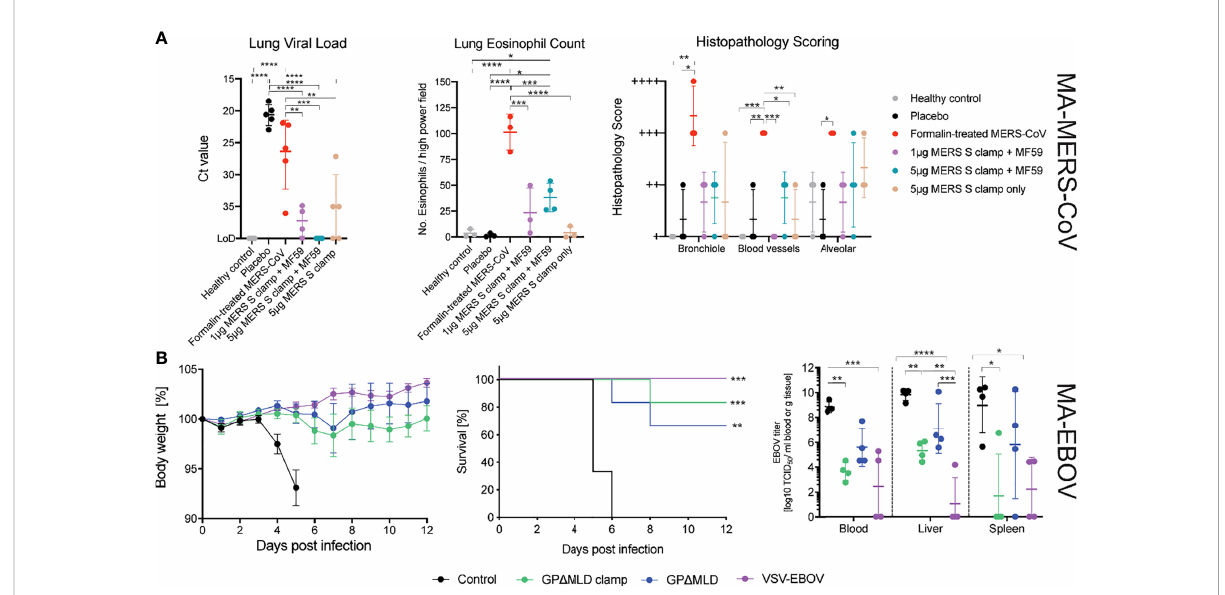
FIGURE 4 MERS-CoV and EBOV challenge models. (A) Congenic C57BL/6 DPP4 knock-in mice were given prime and boost immunisations before challenge with 10 4 PFU of MA-MERS. The tissues were then assessed for in fi ltration of the virus and histopathology. Asterisks indicate statistical signi fi cance calculated by a two-way ANOVA with Tukey ’ s multiple comparisons test. (B) Syrian golden hamsters were immunised with clamped in fl uenza virus H3 hemagluttinin (control), clamp-stabilised and unstabilised recombinant GP D MLD or VSV-EBOV and challenged with 1,000 LD 50 of MA-EBOV (n = 10). Body weights and survival of the hamsters was monitored following the challenge (n = 6). Four days post-challenge, hamsters were euthanized for virological analysis of the blood and tissues (n = 4). Statistics are calculated using a two-way ANOVA grouped analysis with Tukey ’ s multiple comparisons test. Survival curves were analysed with a Mantel-Cox test. Statistical signi fi cance is indicated as: p < 0.0001 (****), p < 0.001 (***), p < 0.01 (**), and p < 0.05